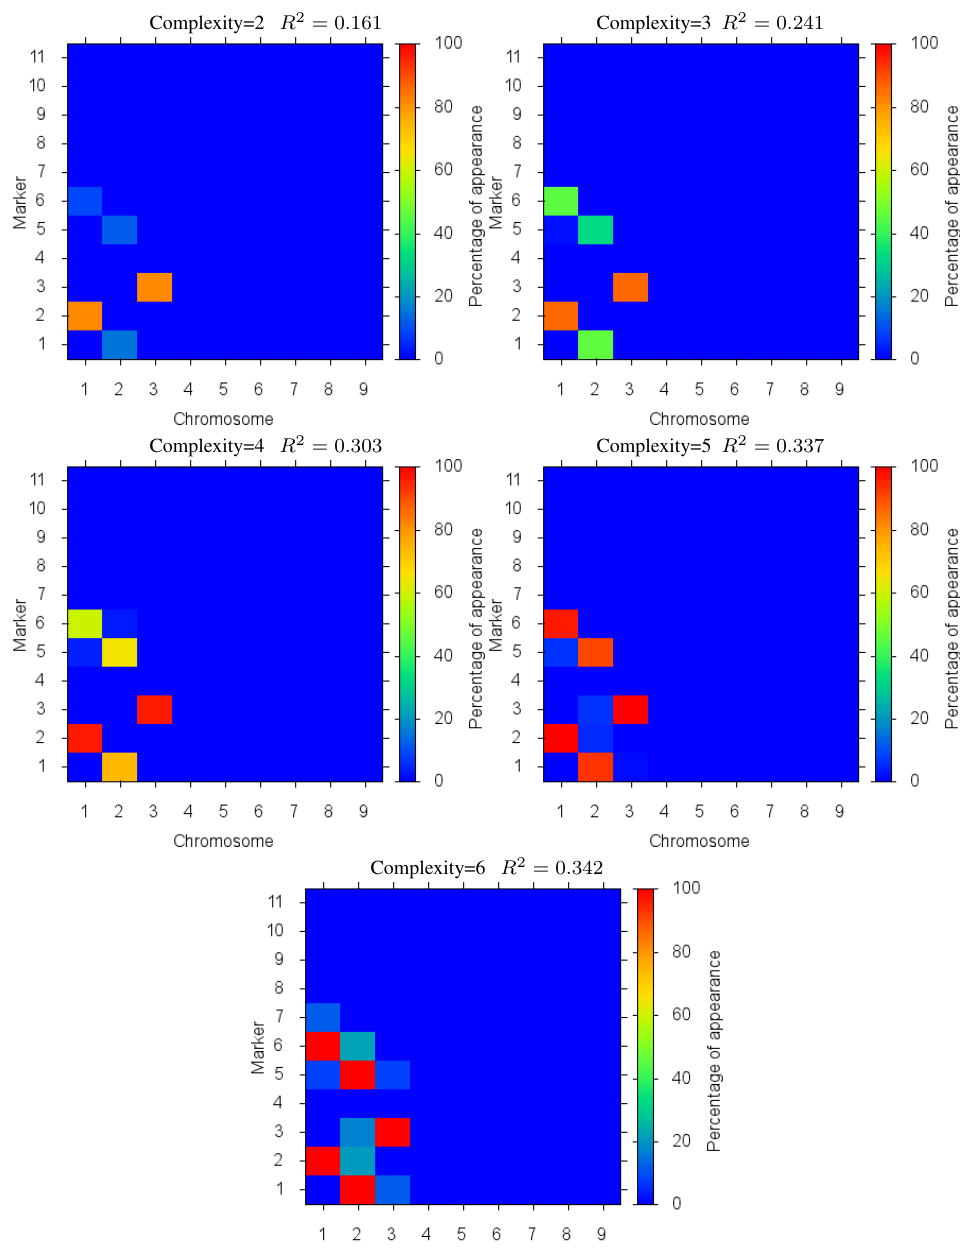
Figure 8. Case III: Markers Identified: in different complexity Pareto optimal solutions for Case III. The color is the proportion of random executions that the specific marker was found. Bright red signifies that in each run the marker was consistently found. Blue means that the marker did not appear in any